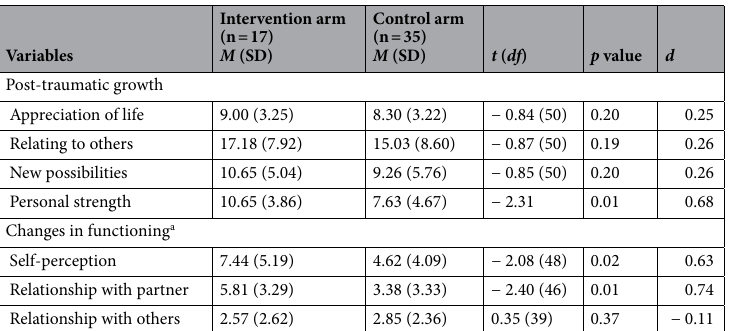
Table 3. Perception of changes in resilience-promoting factors at the post-intervention assessment. a Items used to assess changes in functioning are provided in Supp Methods (see the electronic